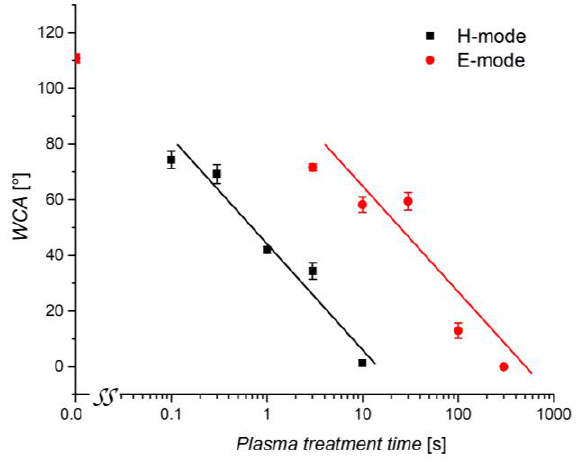
Figure 5. Water contact angle (WCA) on the wheat seed surface after treatment with an E-mode or H-mode plasma at various treatment times. The error bars represent standard error. Mean values (±SE) for the respective triplicates of WCA are given.